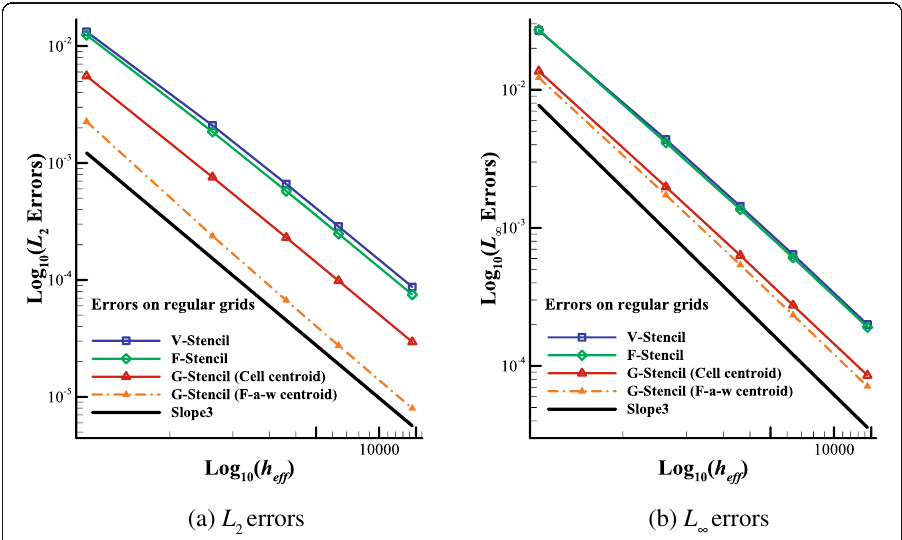
Fig. 38 ( a ) L 2 and ( b ) L ∞ errors. Errors of different stencils on regular triangular grids with AR = 5 × 10